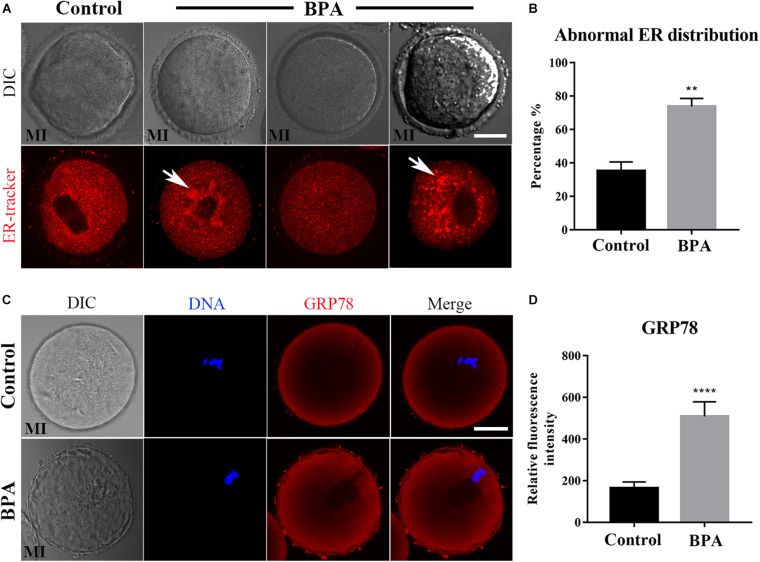
Effects of BPA on endoplasmic reticulum distribution and functions during mouse oocyte maturation. (A) Representative images of ER distribution in the oocyte cytoplasm in the control group and BPA treatment group. In BPA treatment oocytes, ER agglomerated in the cytoplasm (white arrow). Red, ER. Bar = 20 μm. (B) Abnormal distribution of ER significantly increased in the BPA treatment oocytes compared with the control oocytes. **, significant difference (P < 0.01). (C) Representative images of GRP78 intensity in the oocyte cytoplasm in the control group and BPA treatment group. Red, GRP78 antibody; Blue, DNA. Bar = 20 μm. (D) The fluorescence intensity of GRP78 in the BPA treatment group was significantly increased compared with the control group. ****, significant difference (P < 0.0001).